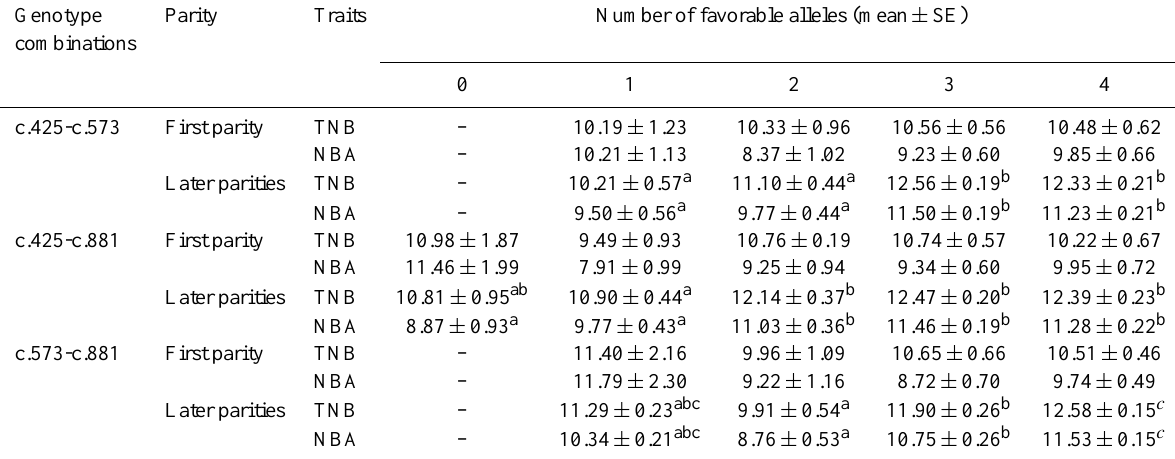
Table 4. Association of genotype combinations of SNP c.425, c.573 and c.881 with litter size traits. Genotype Parity Traits Number of favorable alleles (mean ±